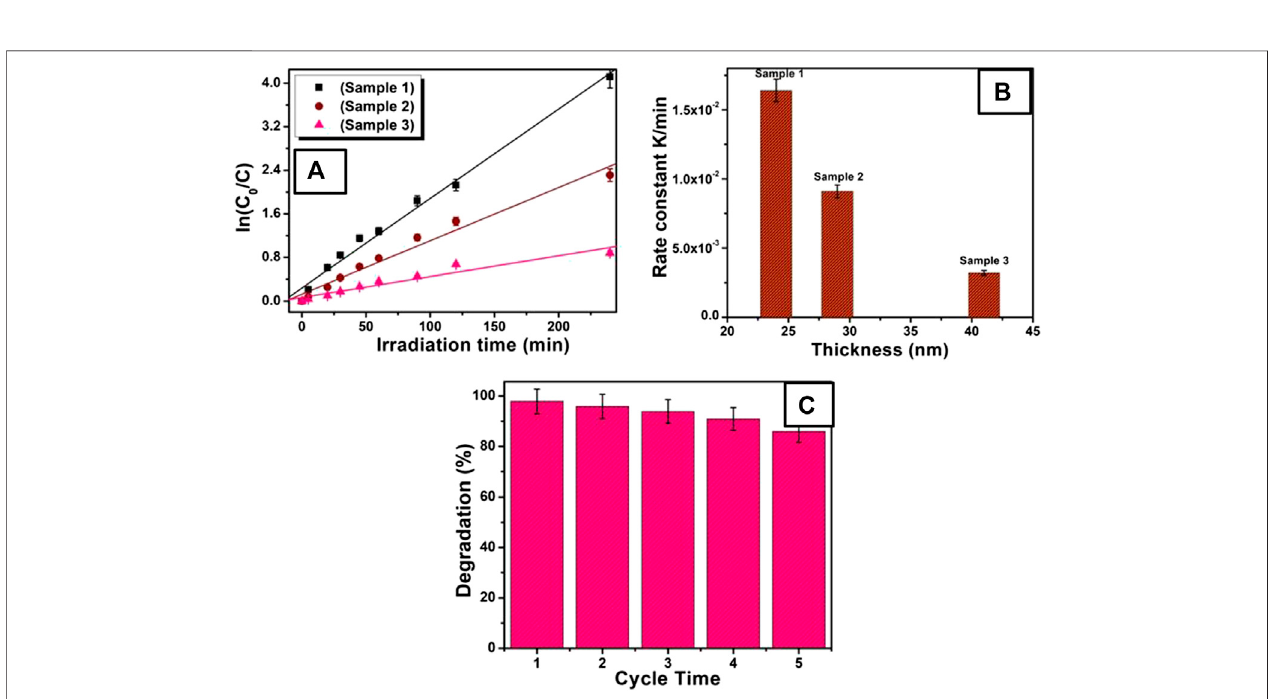
Frontiers in Materials |